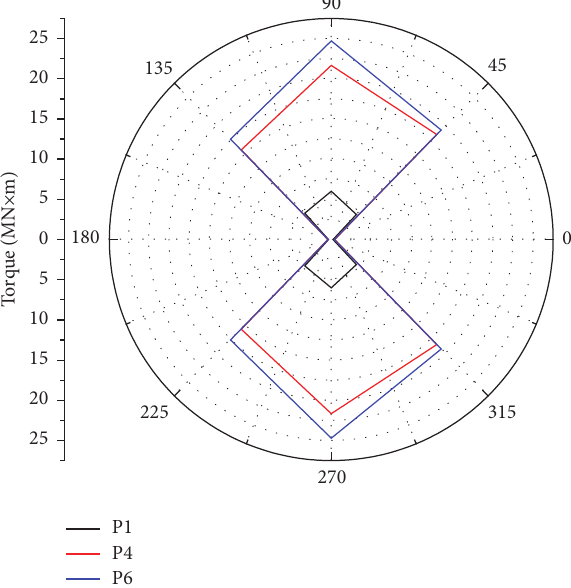
Figure 31: Torque of main hull in different azimuths.